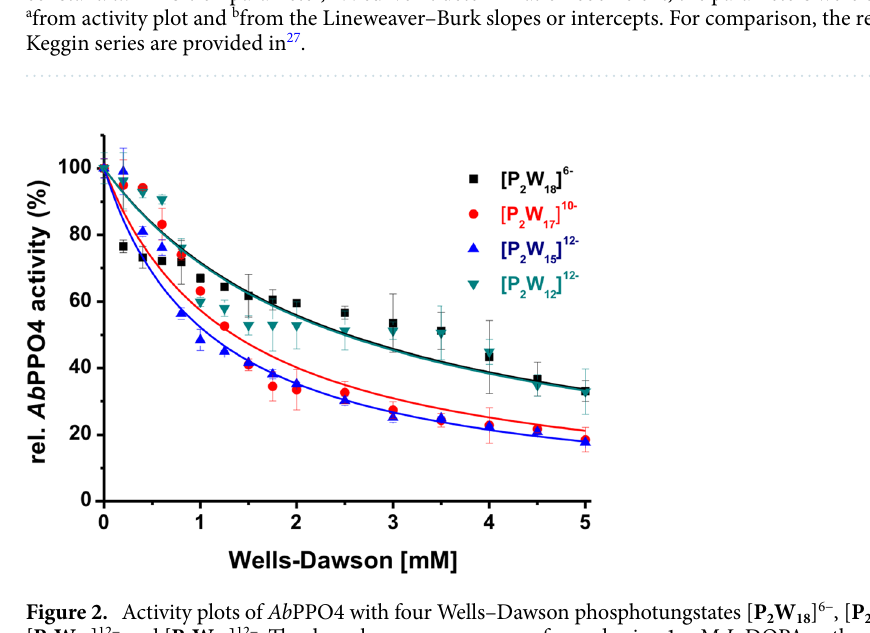
Figure 2. Activity plots of Ab PPO4 with four Wells–Dawson phosphotungstates [ P 2 W 18 ] 6− , [ P 2 W 17 ] 10− , [